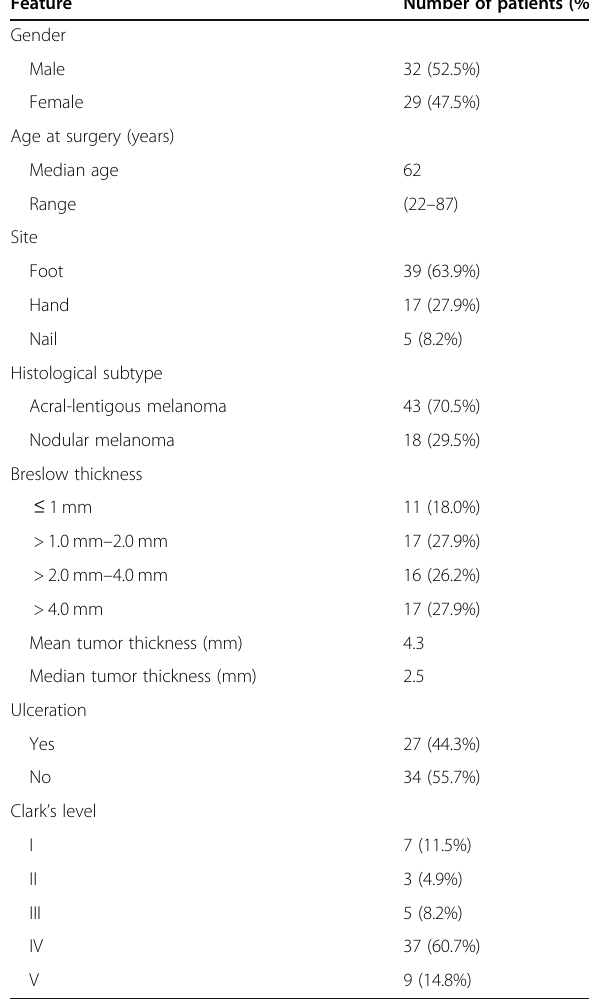
Table 1 Clinical and pathological features of the acral melanoma patients (61